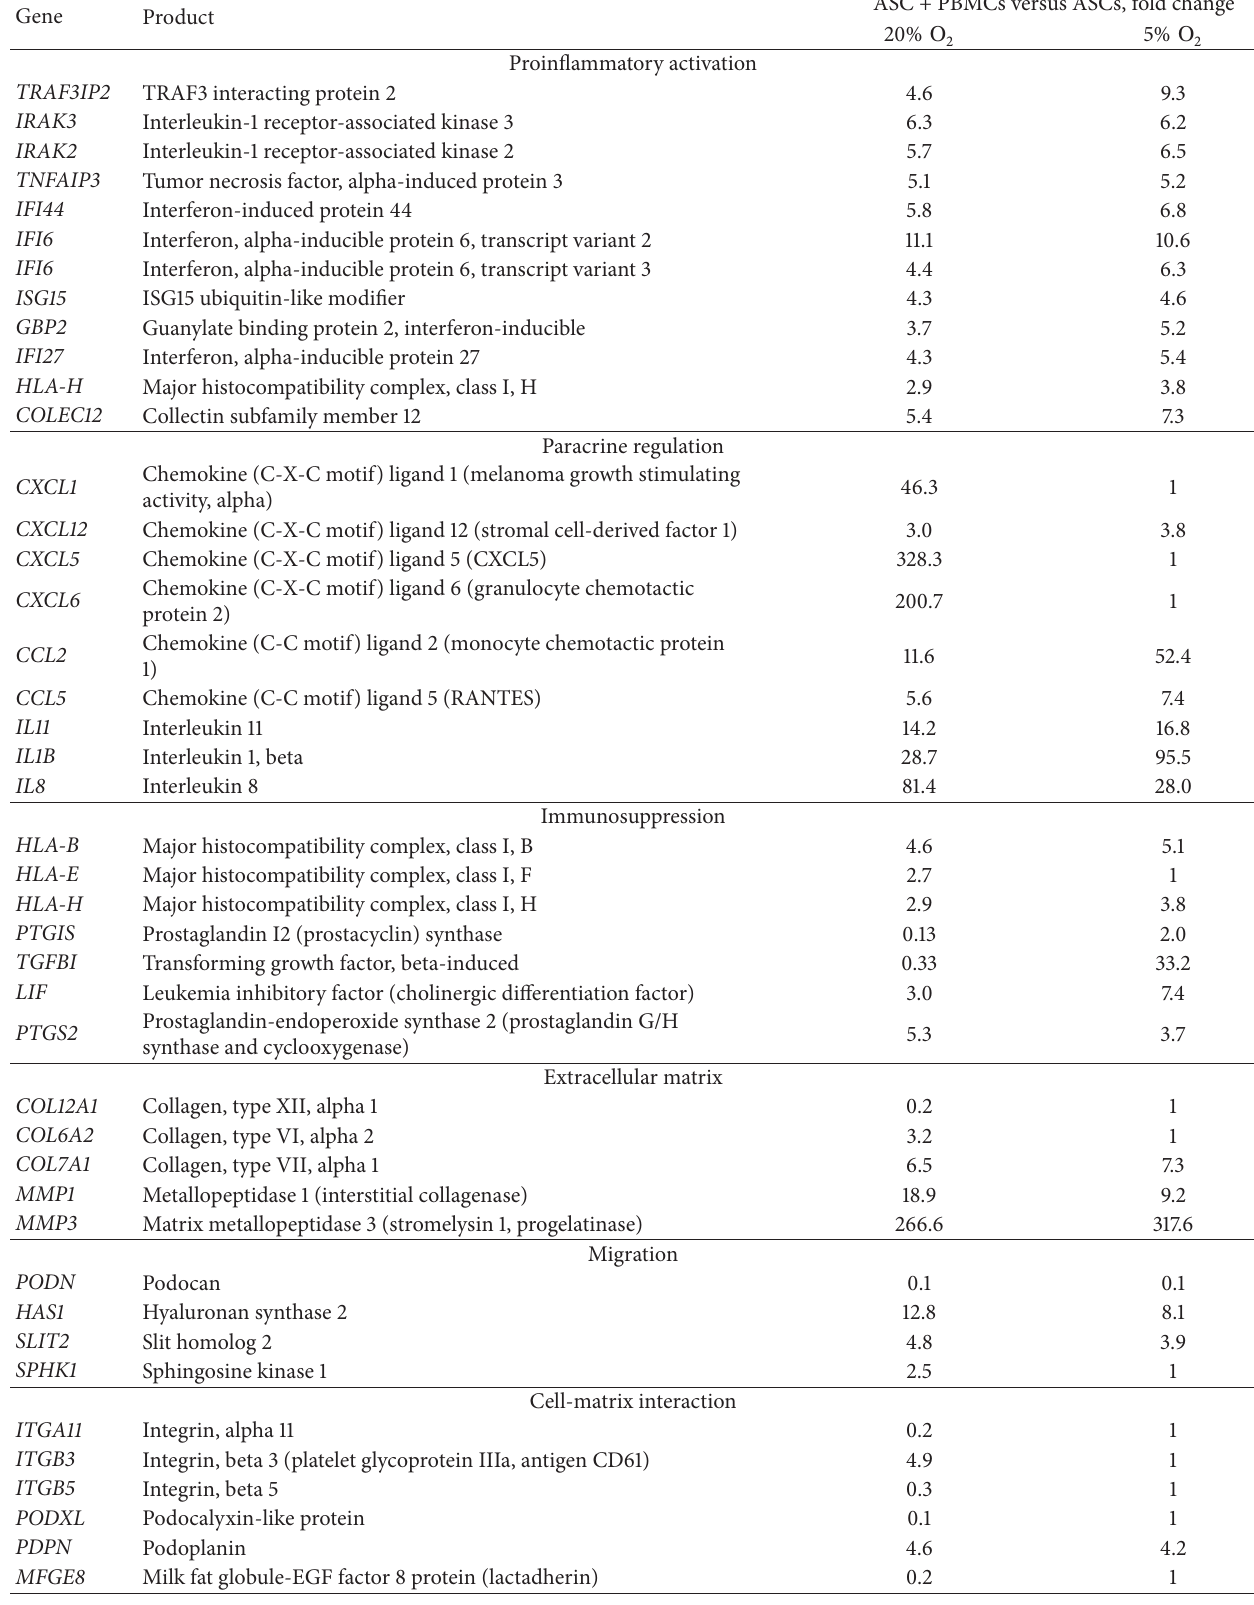
Table 2: Summary of most important differentially expressed ASC genes after paracrine interaction with PHA-stimulated PBMCs under different O 2 concentrations, as determined by microarray